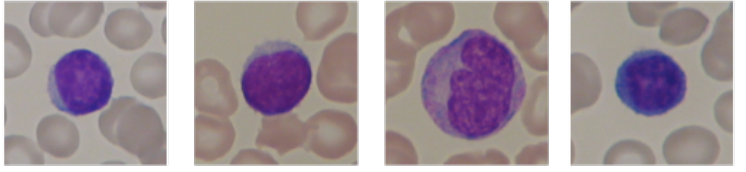
Figure 2. An example of segmented lymphocytes belonging to the non-leukemia class.